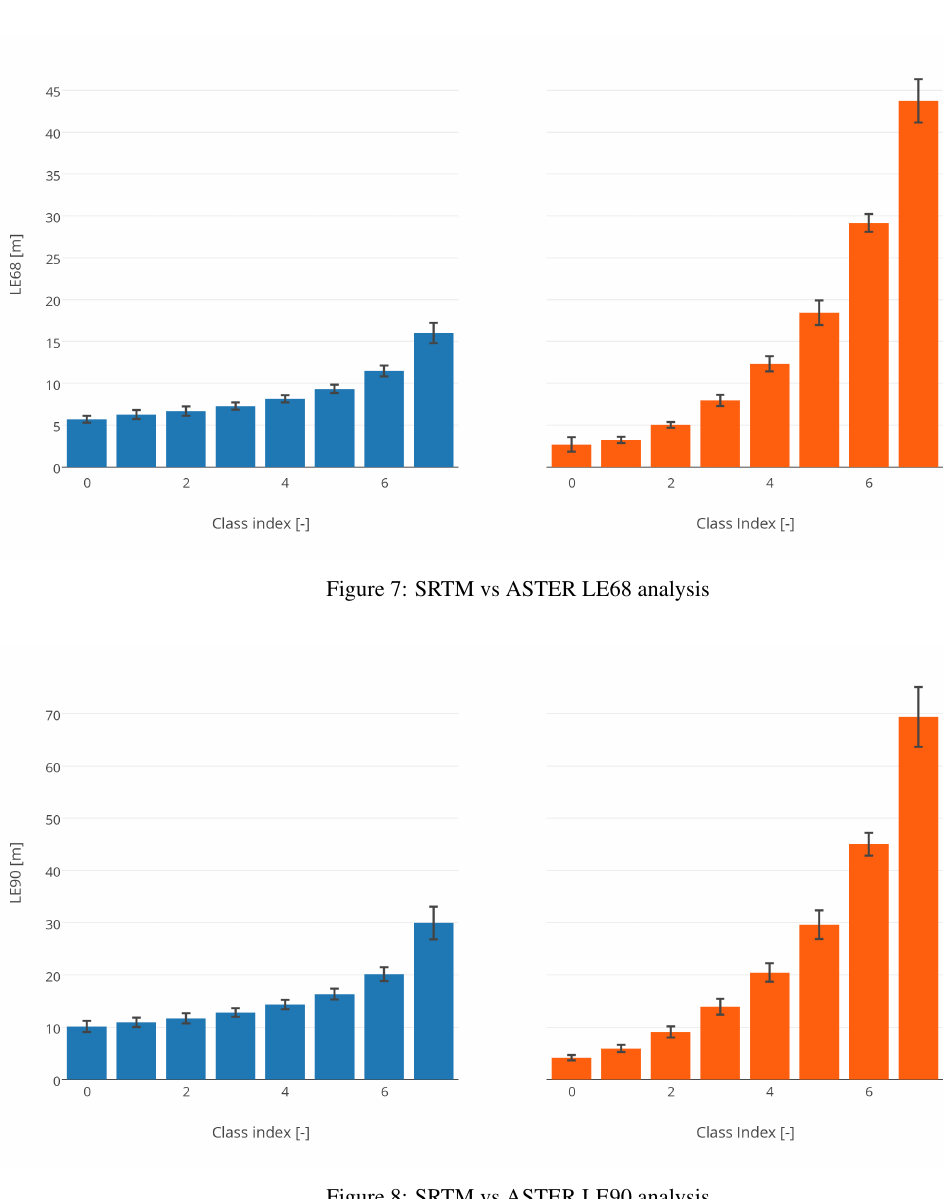
Figure 8: SRTM vs ASTER LE90